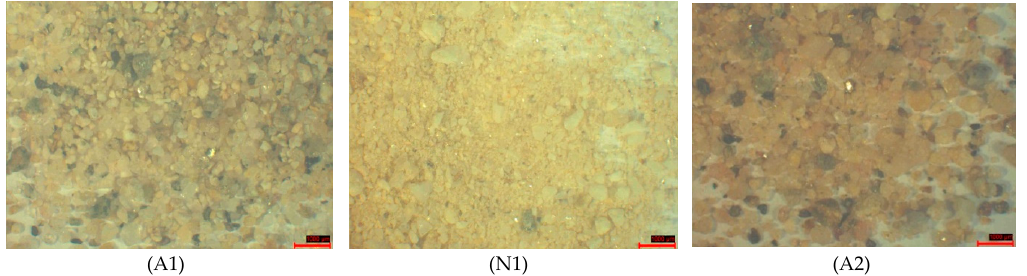
Figure 2. Α 1 ( left ), Ν 1 ( middle ) and Α 2 ( right ) under stereoscope.